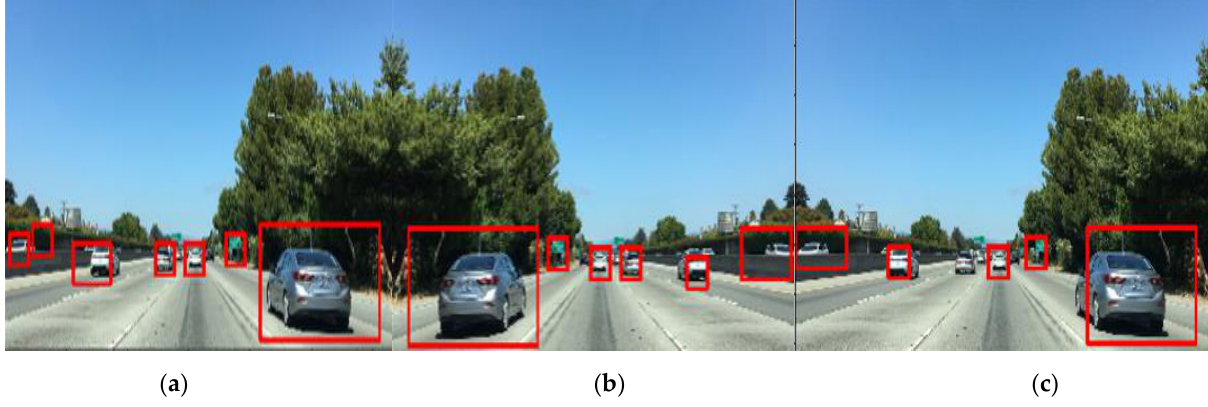
Figure 16. Confidence level effect. ( a ) Confidence = 0.85, the detection windows are too large to contain unnecessary information like the 2nd window from left ( b ) Confidence = 0.88, the detection windows are appropriate and contain the vehicles without omission ( c ) Confidence = 0.90. The 2nd car from left is not detected since confidence is too high.